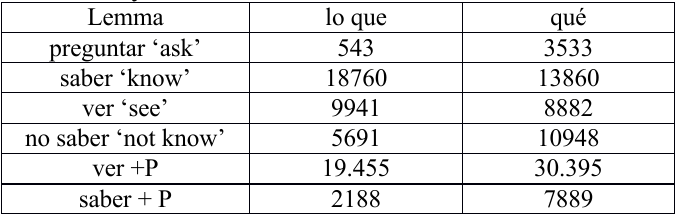
Table 11: synchronic observations Lemma lo que qué preguntar ‘ask’ 543 3533 saber ‘know’ 18760 13860 ver ‘see’ 9941 8882 no saber ‘not know’ 5691 10948 ver +P 19.455 30.395 saber + P 2188